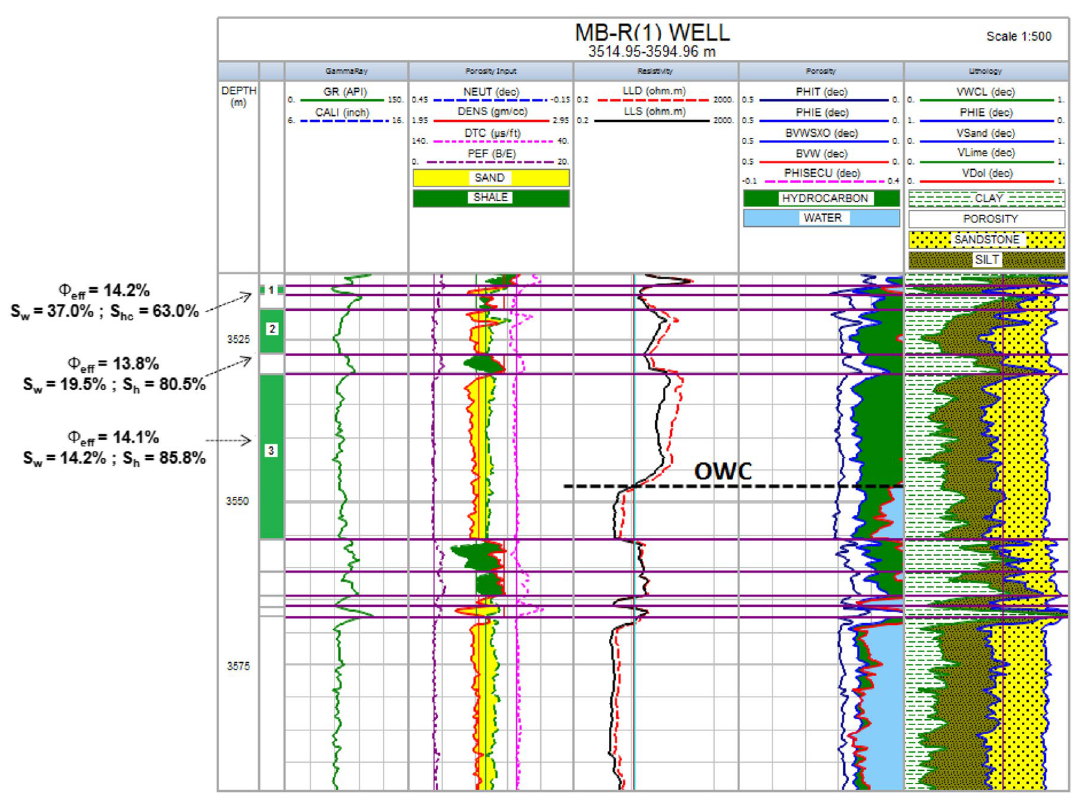
Fig. 12 MB-R(1) Well log interpretation showing three pay zones with Zone 3 as the most promising